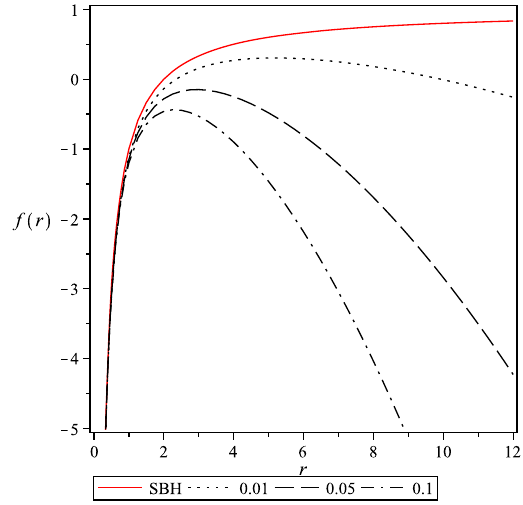
Fig. 1 Variation of lapse-function of unit mass SBH surrounded with cloud of strings string and quintessence with radial distance form the centre; left figure: a = 0 . 1, w q = − 0 . 95 and different values of q as